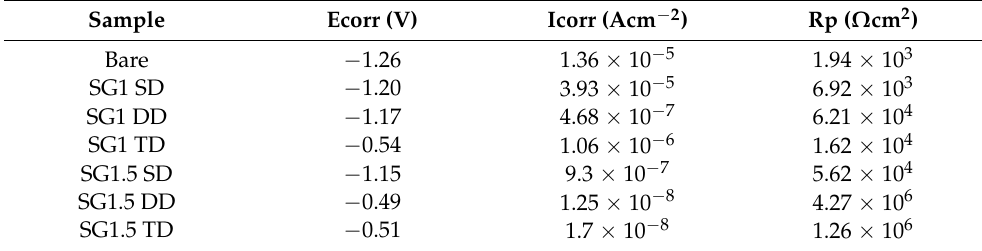
Figure 1. Potentiodynamic polarization curves obtained for uncoated, single, double and triple coated samples. Table 2. Electrochemical parameters obtained from Potentiodynamic polarization curves for uncoated, single, double and triple coated samples .